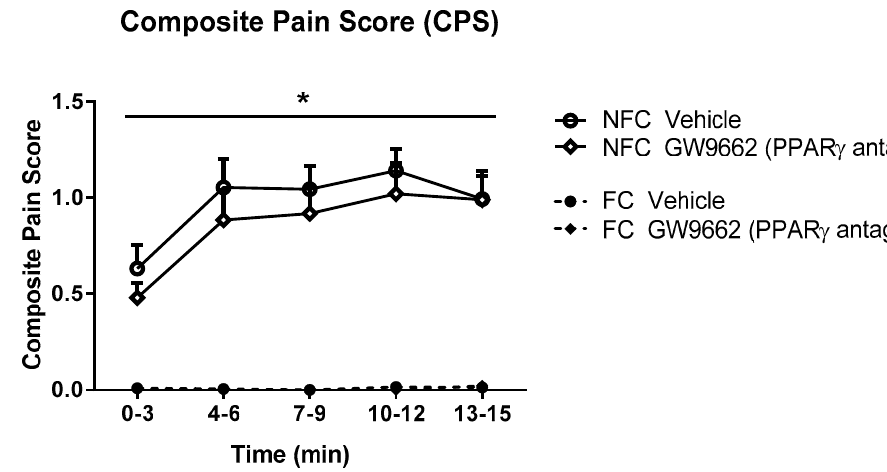
Figure 5. E ff ects of systemic administration of selective PPAR γ antagonist on formalin-evoked nociceptive behaviour in non-fear conditioned (NFC) and fear conditioned (FC) rats. Composite pain score was calculated as (pain 1 + 2 × [pain 2]) / total duration of analysis period. Data (mean ± S.E.M) are represented in 3-min time bins ( n = nine rats per group). According to a repeated measured ANOVA ( p < 0.05), * significant main e ff ect of fear conditioning.